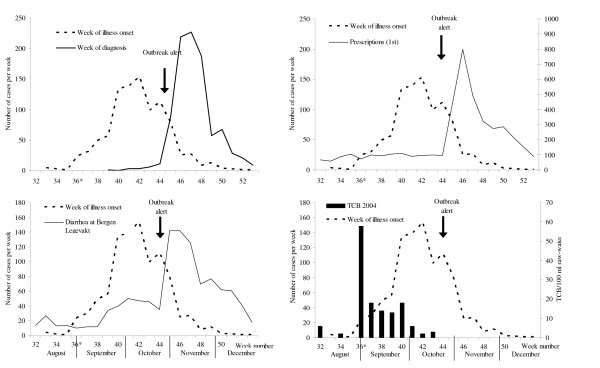
Cases of giardiasis by week of illness onset, Bergen municipality 1/9/2004 – 1/2/2005 (n = 963) and A. cases of giardiasis by week of diagnosis. B. prescriptions of metronidazol delivered from pharmacies to persons in Hordaland per week. C. number of consultations for diarrhoeal illness per week at Bergen legevakt. D. Termotolerant coliform bakteria (TCB) in raw water samples from watersupply A.